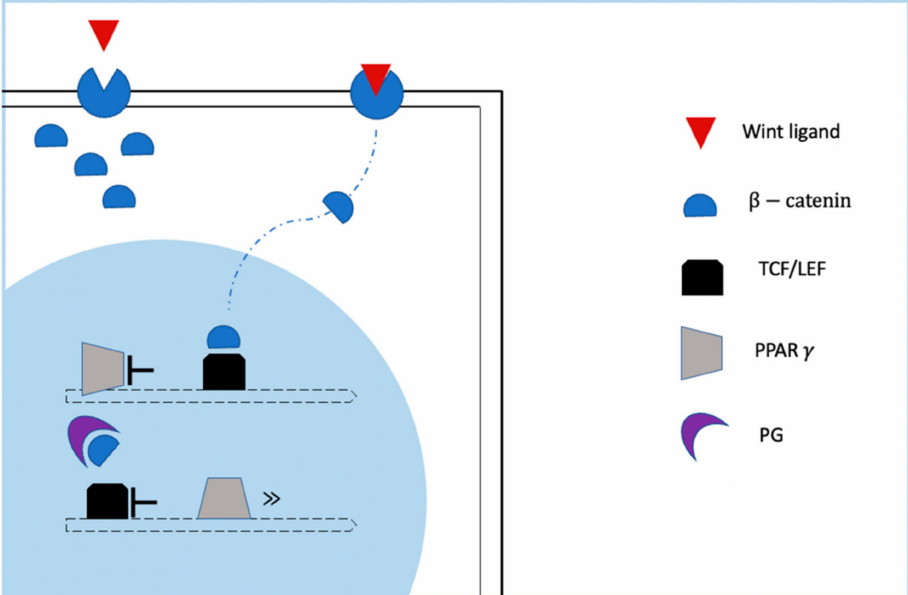
Figure 1. Interferences in Wnt/ β -catenin pathway contribute to ACM pathogenesis. Binding of Wnt ligands to their receptors allows the translocation of β 1-catenin to the nucleus, where it coactivates target genes of the Tcf/lef transcription factor family. On the other hand, in the absence of Wnt ligand-receptor, the intracellular β 1-catenin is rapidly degraded by a cytoplasmic destruction com- plex. Nuclear PG localization has been proposed to contribute to ACM pathogenesis by suppressing canonical Wnt signaling interfering with β 1-catenin transcriptional activities, thereby enhancing adipogenesis driven by PPAR γ